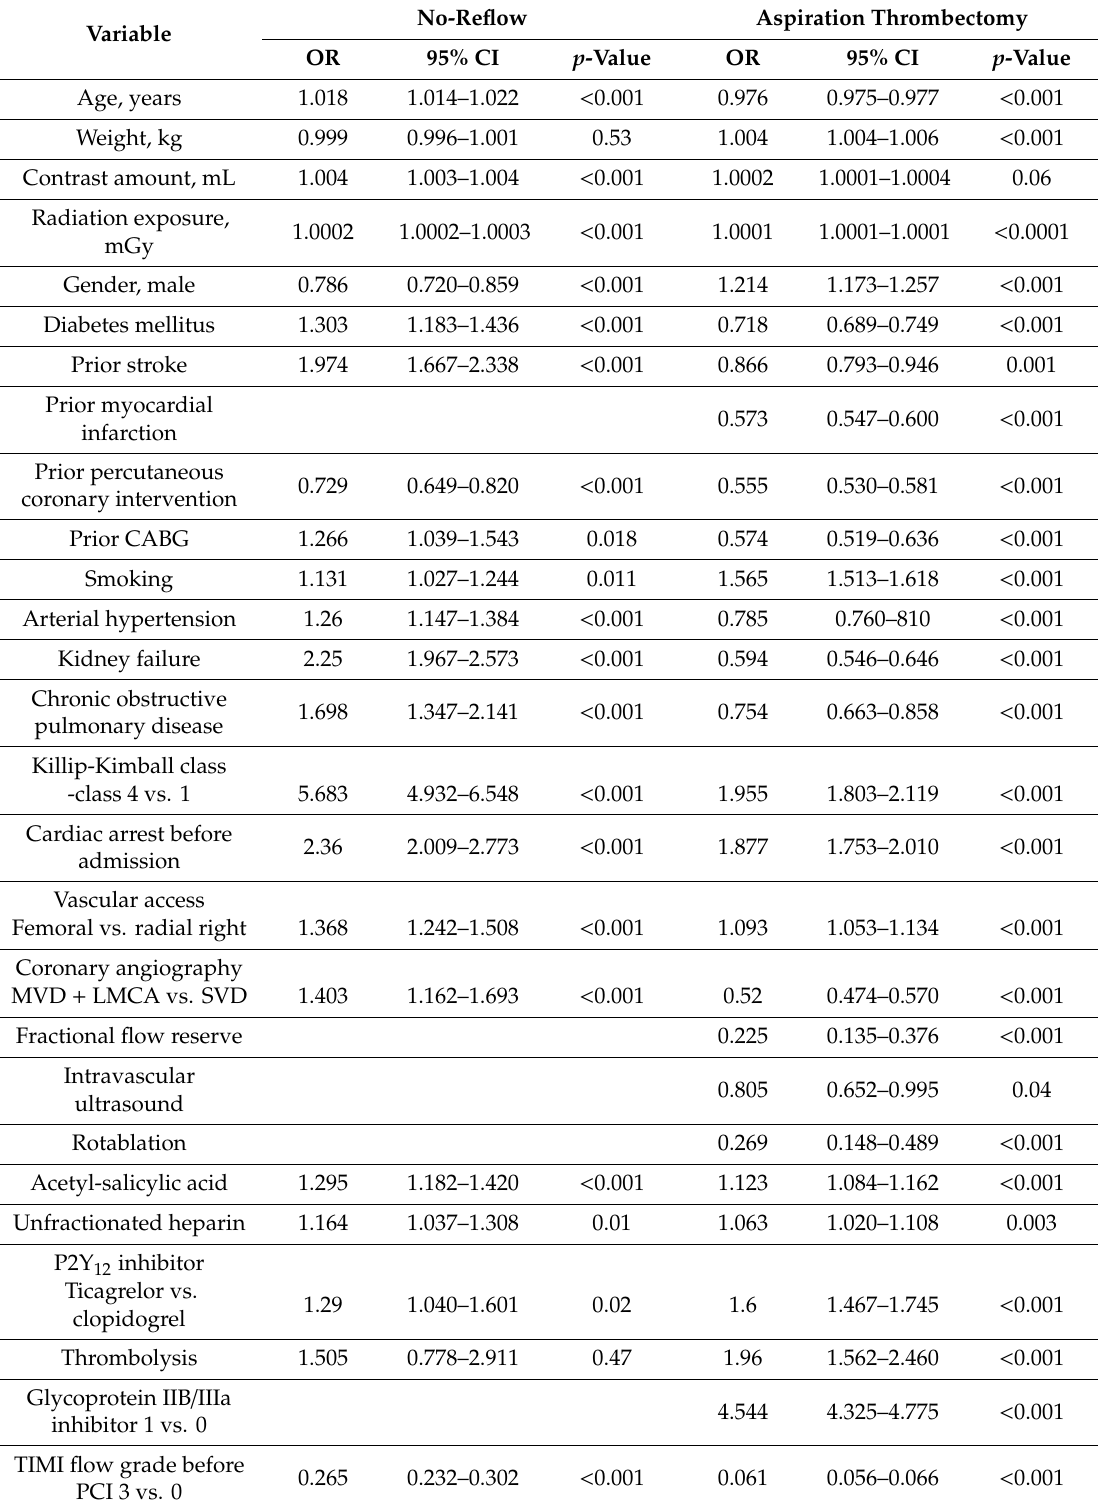
Table 4. Predictors of aspiration thrombectomy and no-reflow in patients with acute myocardial infarction (AMI)—univariate